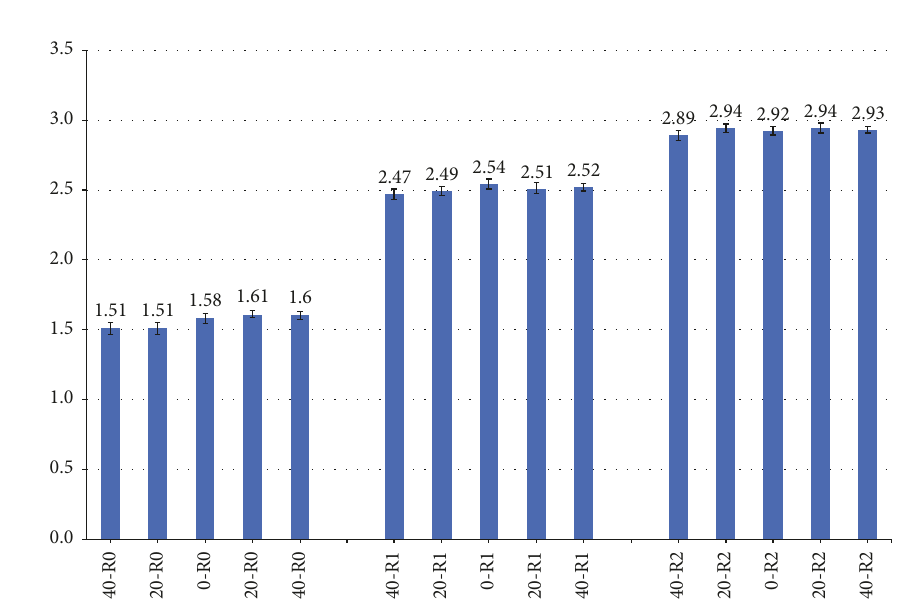
Figure 24: Bond splitting strength under different interface types and different